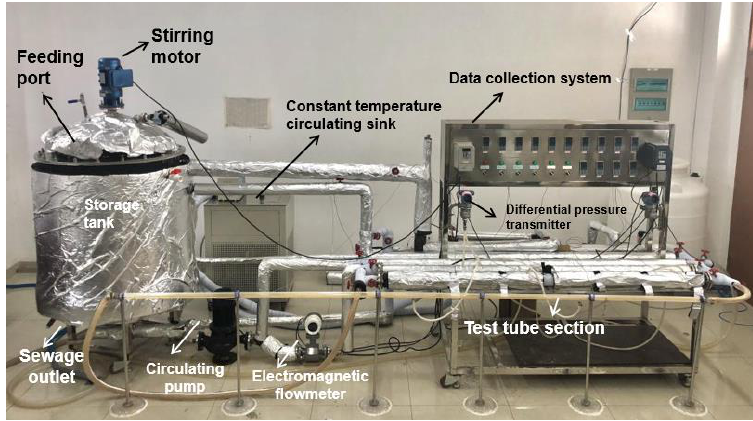
Figure 3. The physical layout of the experimental device. Table 1. Specific parameters of the experimental equipment.